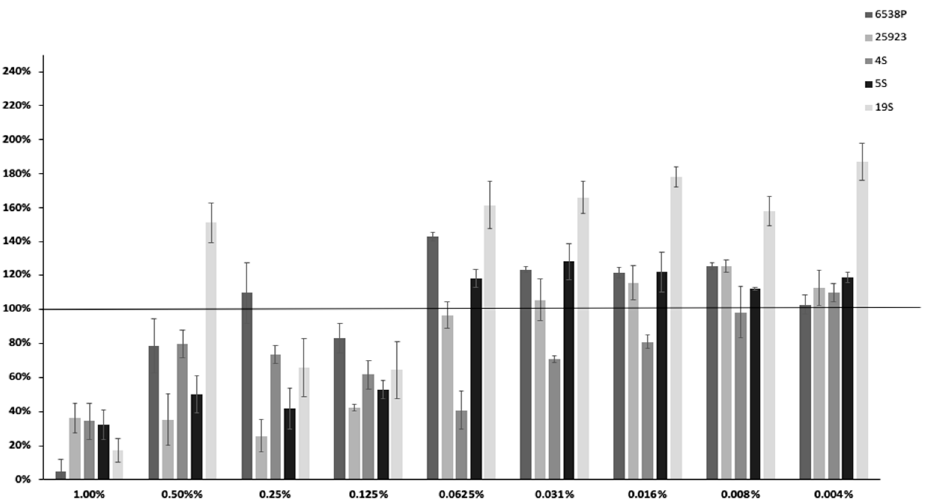
Figure 1. Dose-dependent effect of EO45 on different clinical and reference strains starting from a concentration of 1% to 0.004% v / v . In the ordinate axis is reported the percentage of bacterial biofilm production. Data are expressed as percentage of residual biofilm after the treatment in comparison with untreated one. Each data point is composed of four independent experiments each performed at least in three